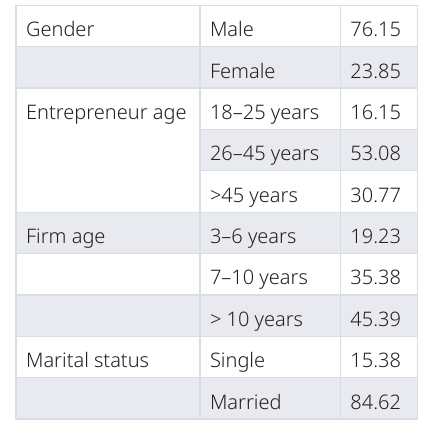
Table 2. Characteristics of the sample (% of respondents, n = 130).